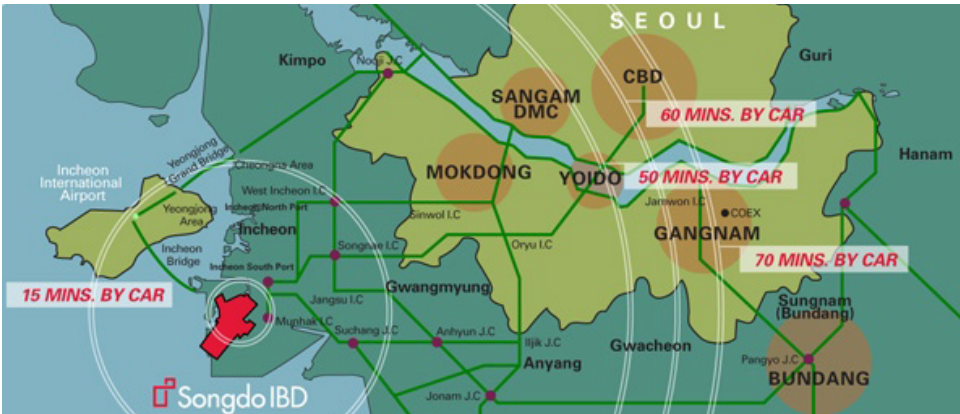
Figure 5. Commuting to Songdo by car. Source: Gale International